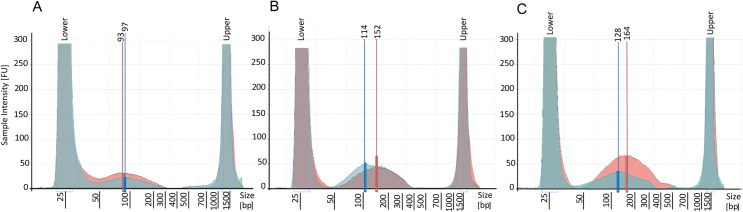
Comparison of fragment sizes between two protocols from three specimens.Electropherograms from the DNeasy extraction Kit (blue) and the Monarch PCR & DNA Clean-up Kit (red). The specimens individual MTD-TW numbers are as follows: A 9248, B 9252, C 9251. See Supplementary Table 1 for more details on the DNA yield from each extraction.